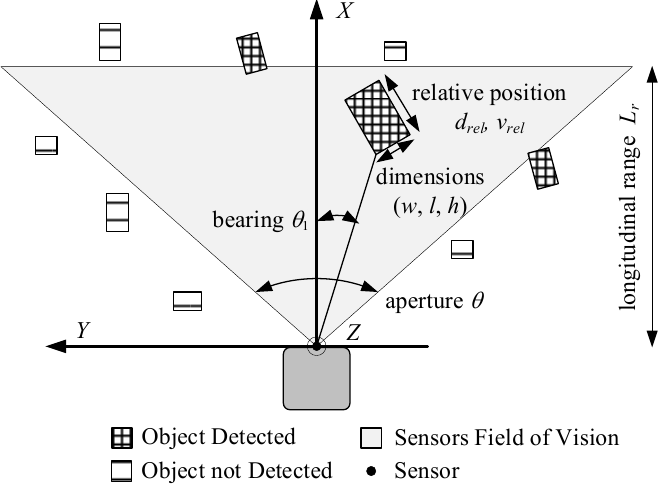
Figure 5. Schematic diagram of the radar sensor. When there are obstacles within the detection range of the radar sensor, the obstacles are classified and marked according to the relative distance. The relative distance, relative angle, length, width, and height of obstacles are saved in matrix form. The spatial position of the object detected by the passenger car radar sensor can be expressed as: